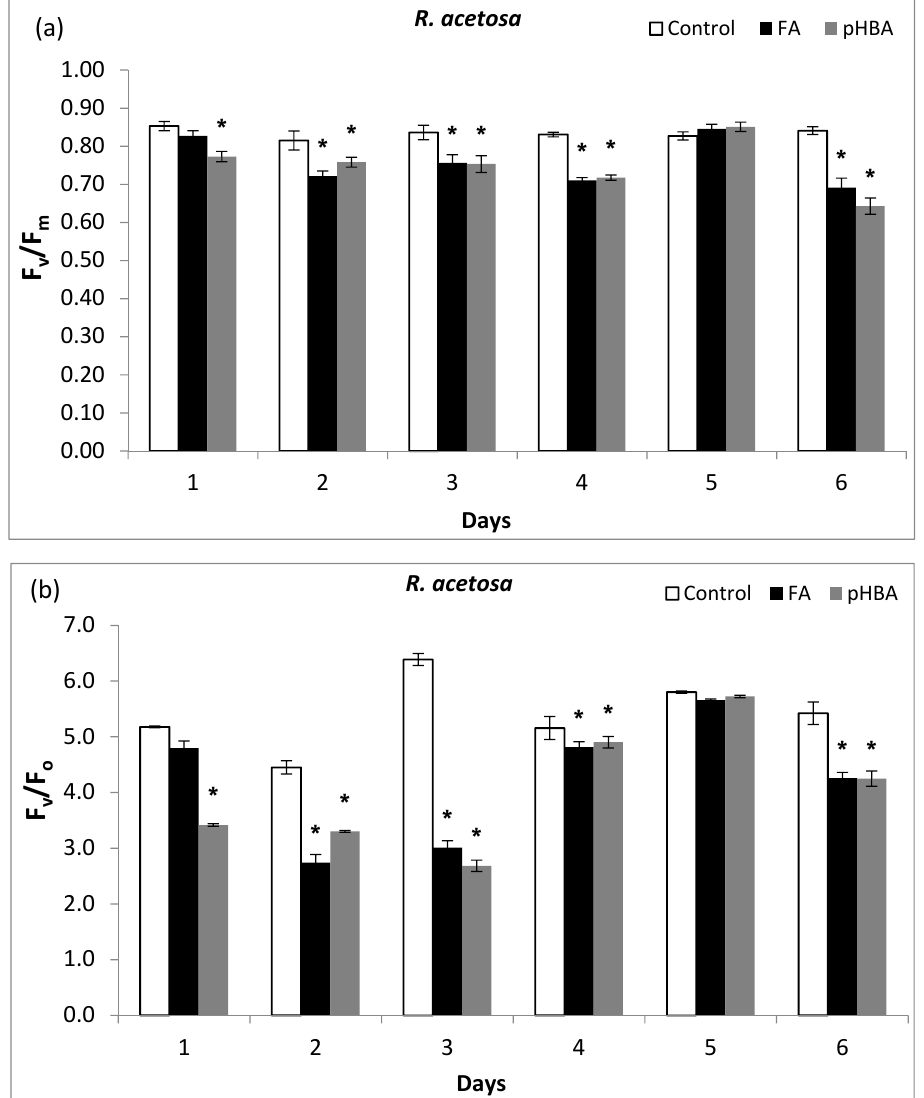
Figure 1. Changes in quantum efficiency of photosystem II PSII in the dark-adapted state (F v /F m ) ( a ), and water-splitting complex values on the donor side of PSII (F v /F o ) ( b ) in leaves of Rumex acetosa from days 1 to 6 following exposure to ferulic acid (FA) and p -hydroxybenzoic acid at 1.5 mM concentration. Every column in each graph represents the mean ( ± S.E.) of three replicates. * Asterisks indicate significant differences at p ≤ 0.05 with respect to control.